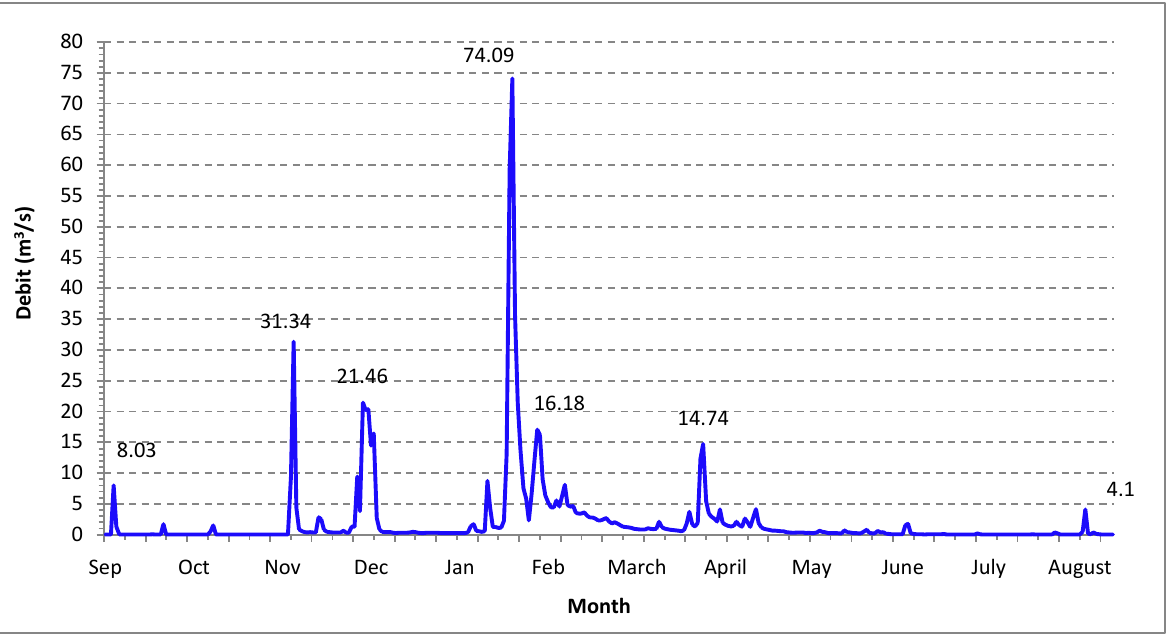
Figure 31. Fluctuation in daily debits for exceptional year